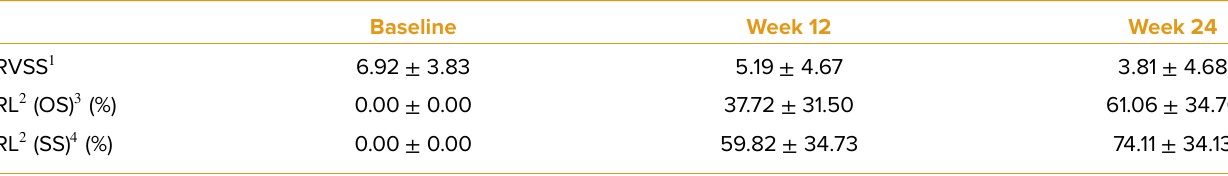
Table 4. Changes in retinal vasculitis scoring system (RVSS) and response level (RL) from baseline to week 12 and week 24. P -value was < 0.001 for the 24-week change of study indices by repeated measures analysis of variance without applying correlation between fellow eyes, as well as comparison of baseline and week 12, baseline and week 24, and weeks 12 and 24 with applying correlation between fellow eyes.